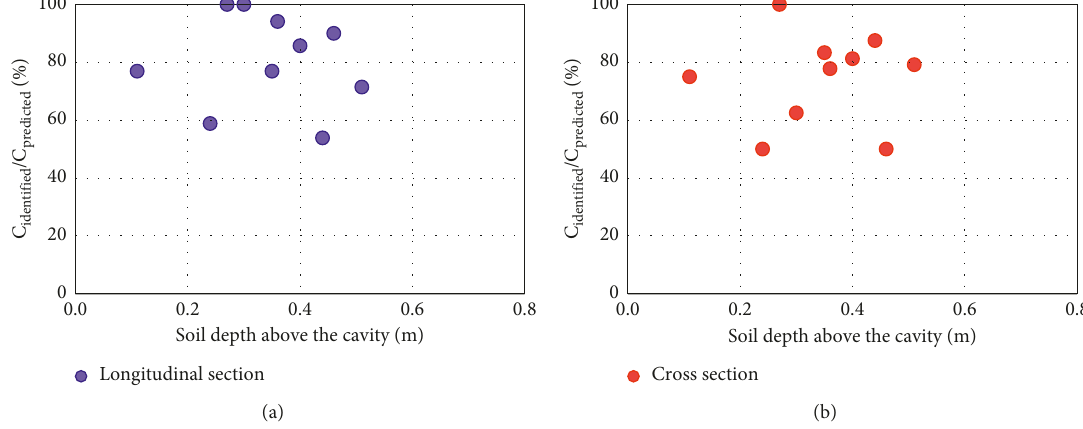
Figure 10: Relationship of the cavity scale ratio according to the soil depth. (a) Longitudinal section. (b) Cross